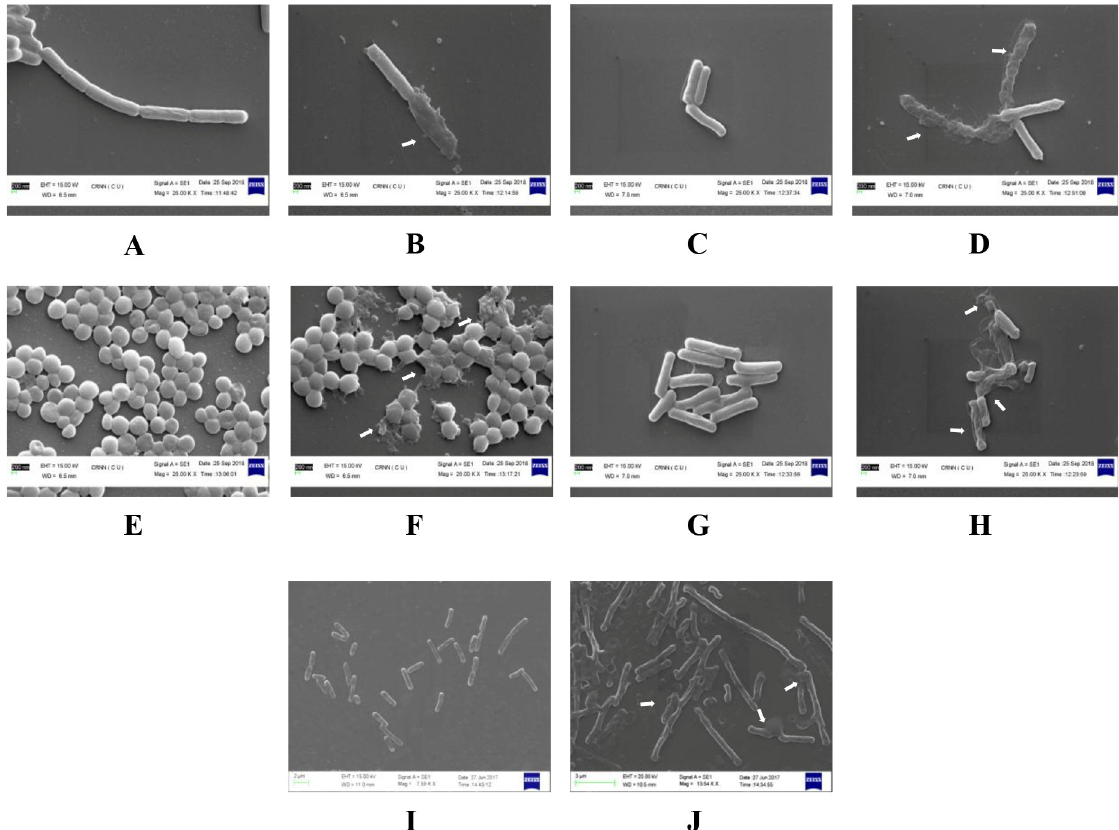
Fig 4. Effect of ethyl acetate fraction of AE1 on the morphology of pathogenic bacteria found during SEM studies: A- B . subtilis (untreated); B- B . subtilis (treated); C- L . monocytogenes (untreated); D- L . monocytogenes (treated); E- S . aureus ( untreated); F- S . aureus (treated); G- S . typhimurium (untreated); H- S . typhimurium (treated); I- E . coli (untreated); J- E . coli